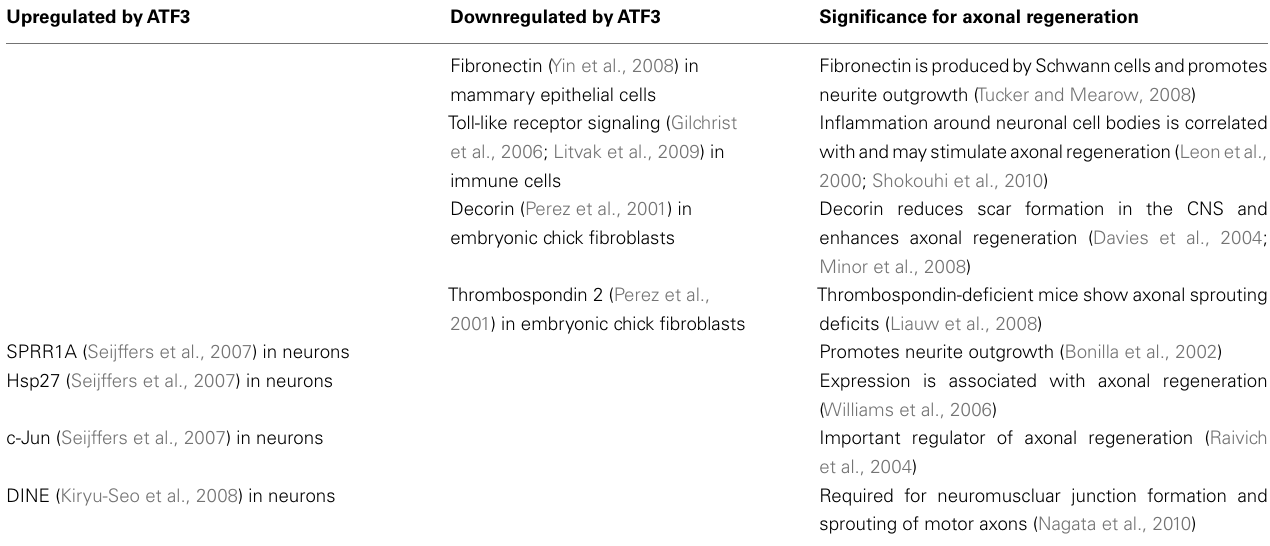
Table 1 | Genes and signaling pathways related to axonal regeneration that are regulated